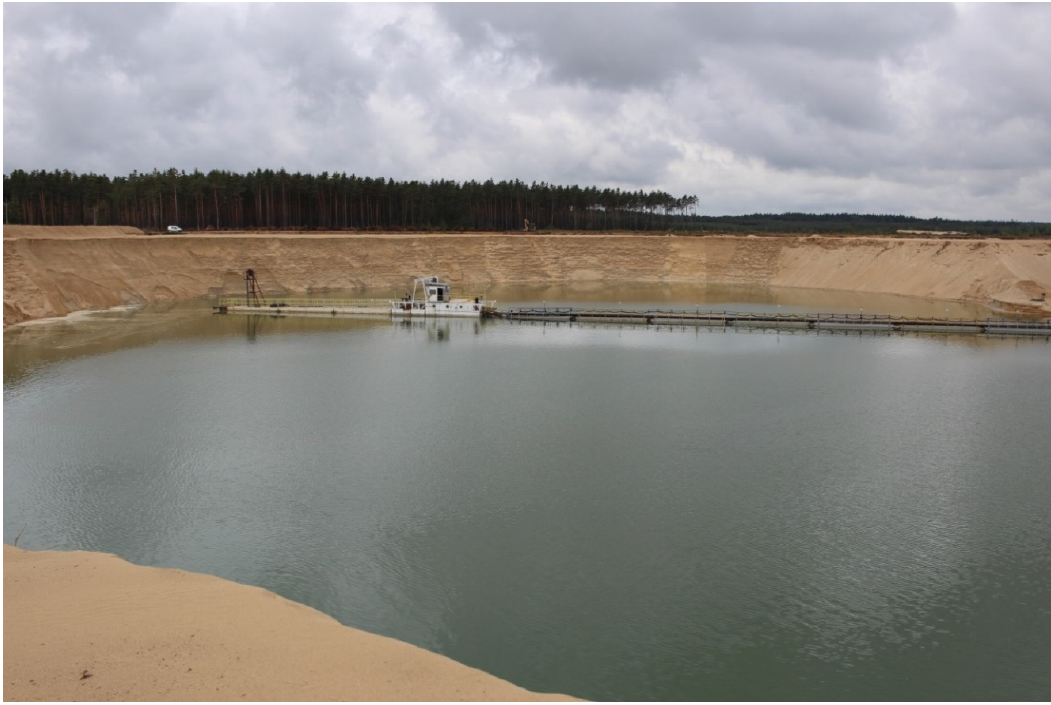
Figure 7. Halámky feldspar deposit: underwater extraction by a suction dredger. Photo: Jakub Figure 7. Hal á mky feldspar deposit: underwater extraction by a suction dredger. Photo: Jakub Jirásek, 2019. Jir á sek,